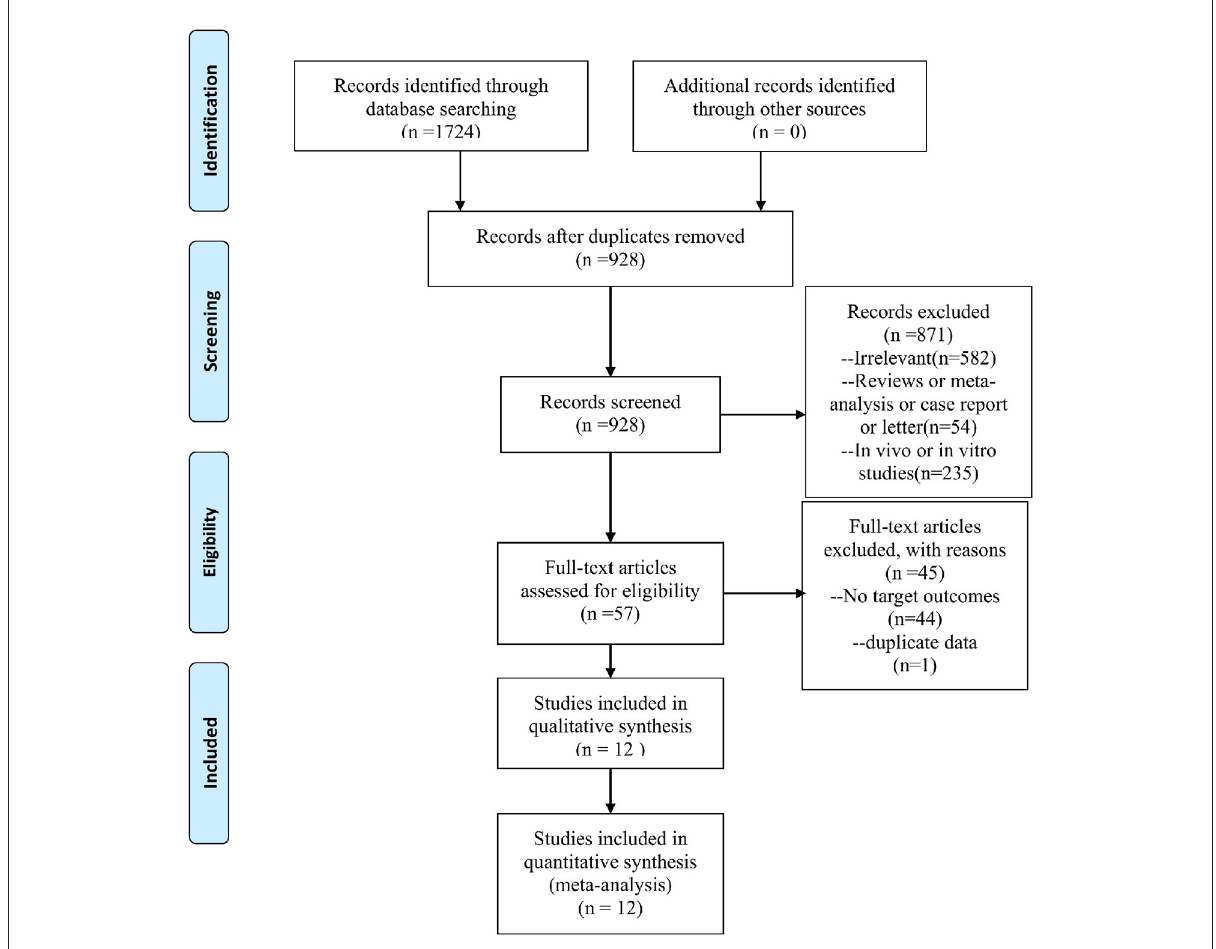
FIGURE1 PRISMA flow